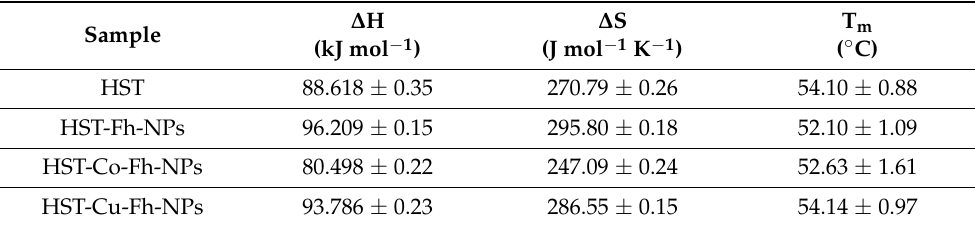
Table 2. Thermodynamic fingerprint of HST denaturation in the absence and presence of simple and doped Fh-NPs.